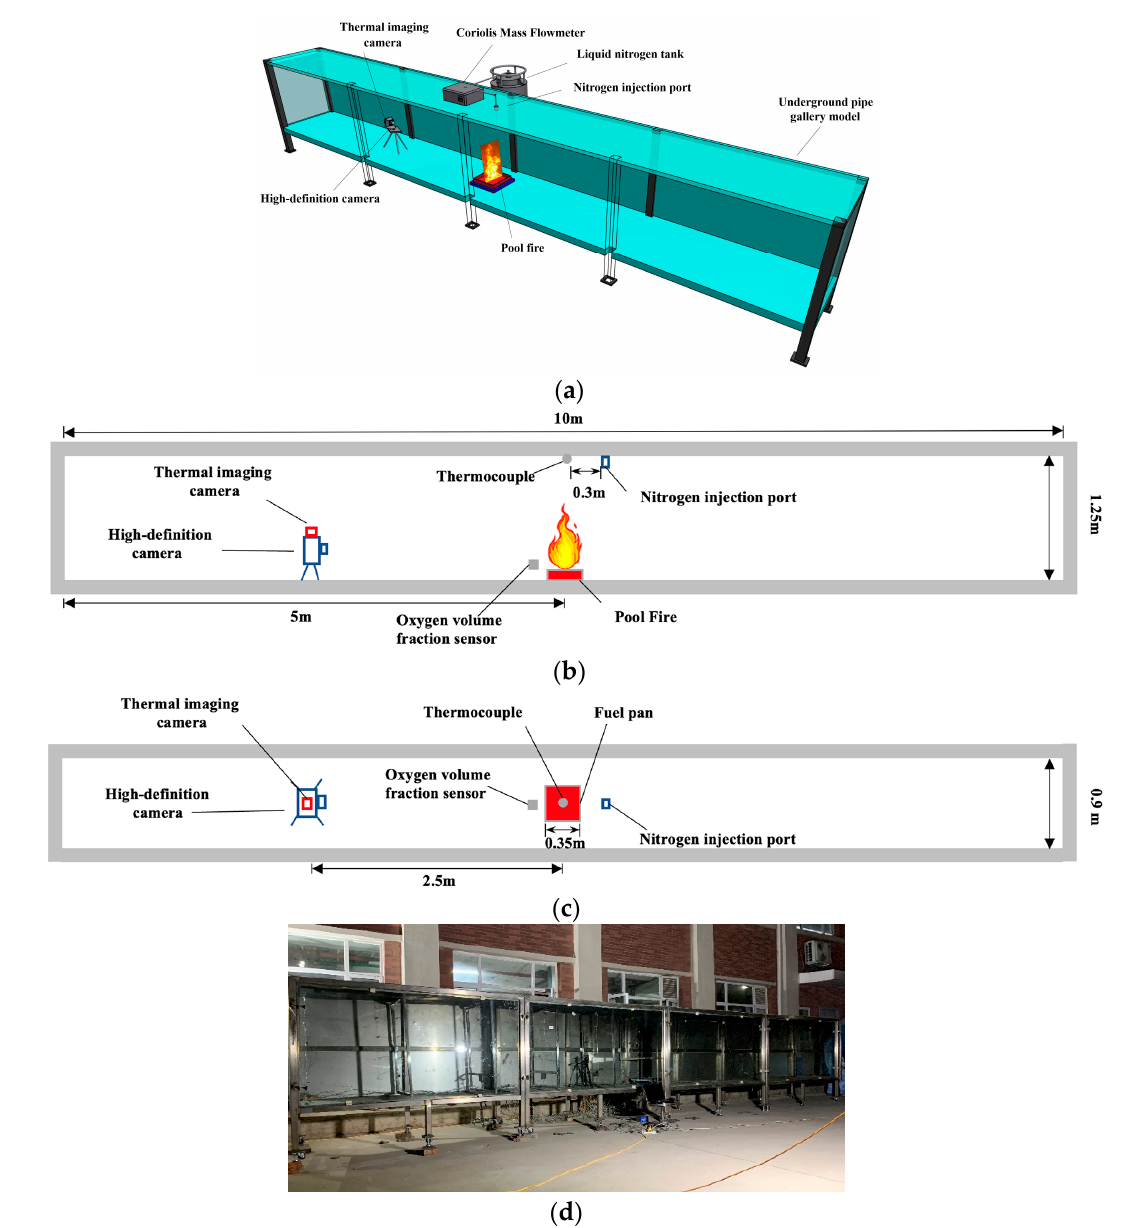
Figure 1. The liquid nitrogen fire extinguishing test system for the underground confined space. ( a ) Overall view; ( b ) front view; ( c ) overhead view; ( d ) photo of the underground pipe gallery model.